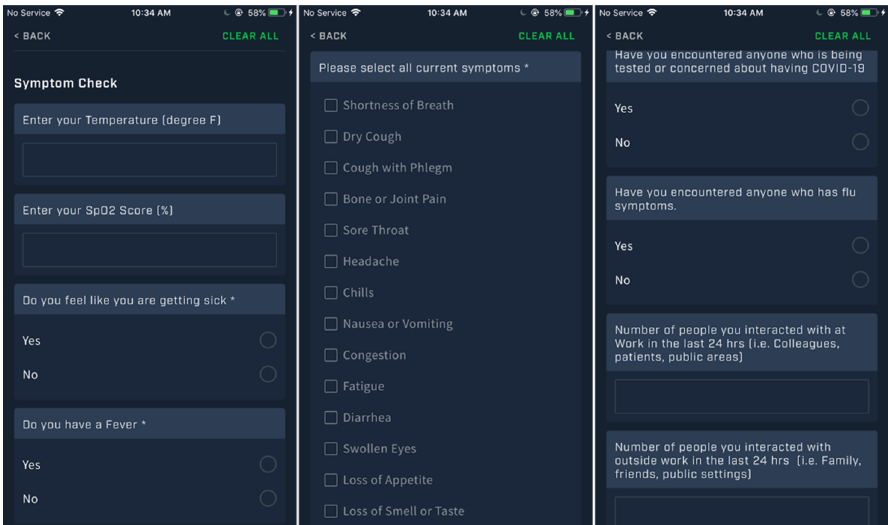
Figure 2. COVID-19 Monitoring and Symptom Daily Questions.